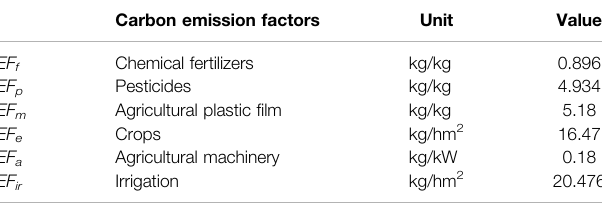
TABLE 3 | Speci fi c values of carbon emission factors (Xu et al., 2018). Carbon emission